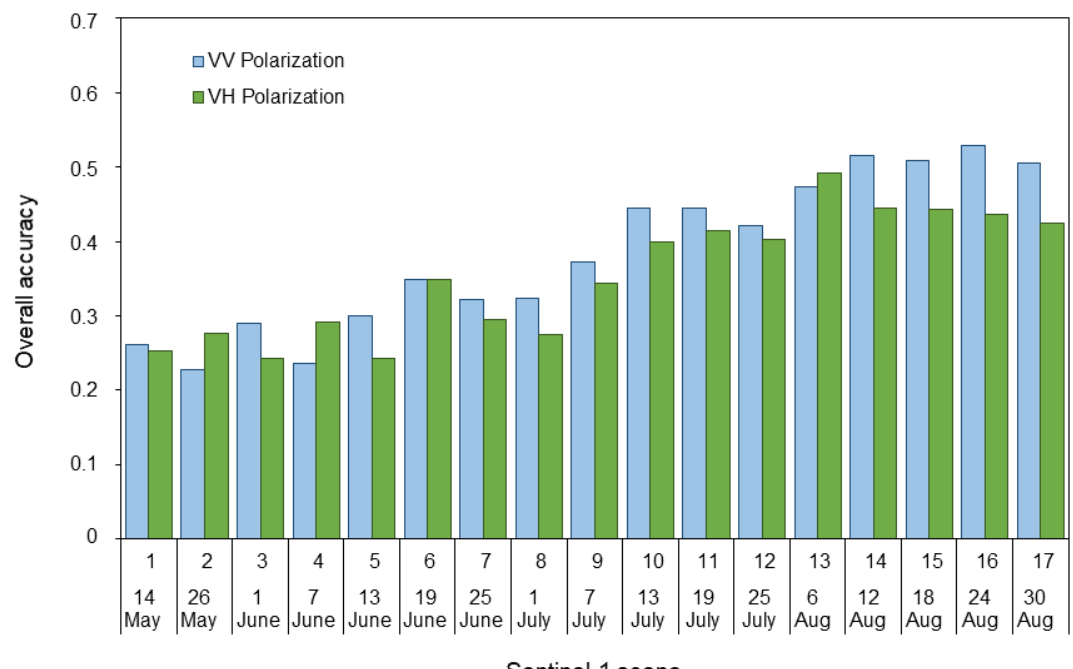
Figure 8. Overall accuracies when using a single Sentinel-1 scene and either VV or VH polarization calculated and the minimum sizes of the parcels of two hectares.